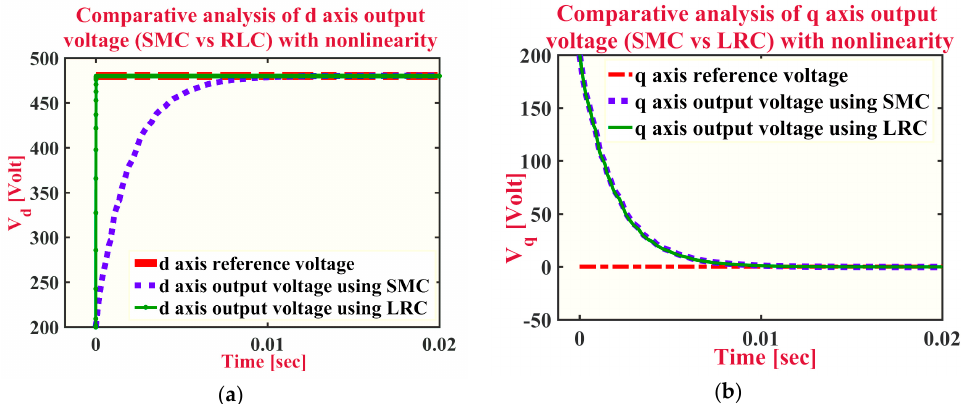
Figure 11. Comparison of performance between SMC (colored in blue) and LRC (colored in green) for nonlinearity in case of ( a ) d-axis output voltage, ( b ) q-axis output voltage. Unlike SMC, LRC is capable of attaining the reference d-axis value with negligible time-delay.